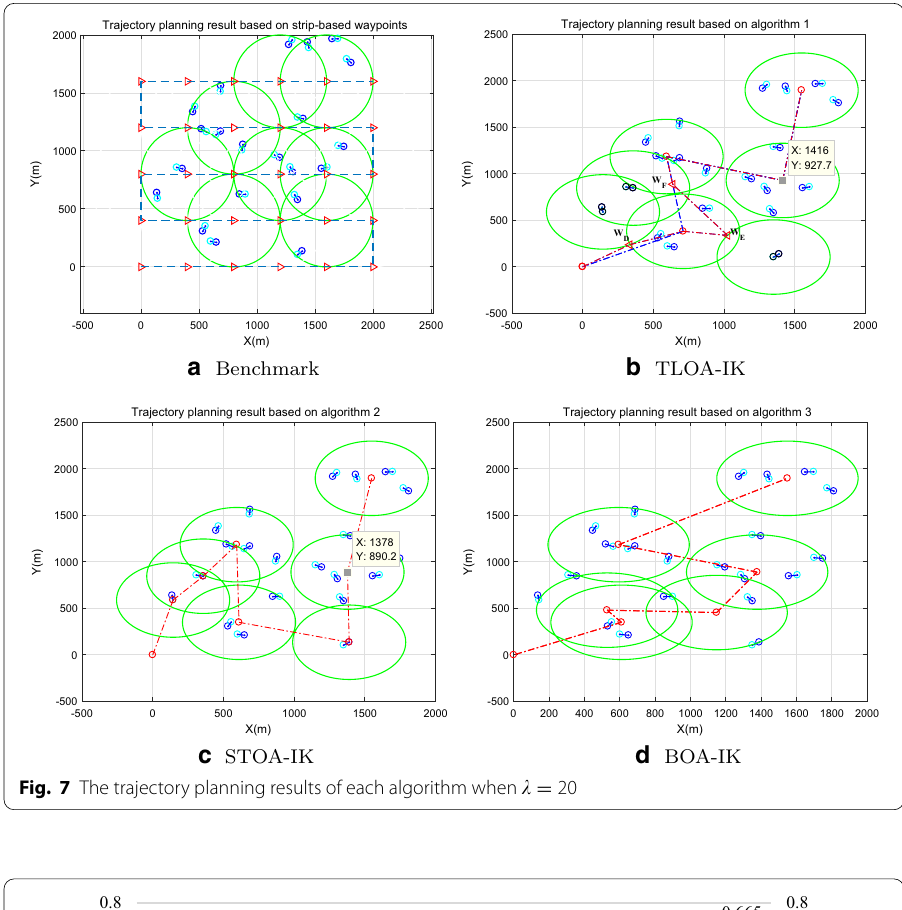
Fig. 7 The trajectory planning results of each algorithm when (cid:31) = 20